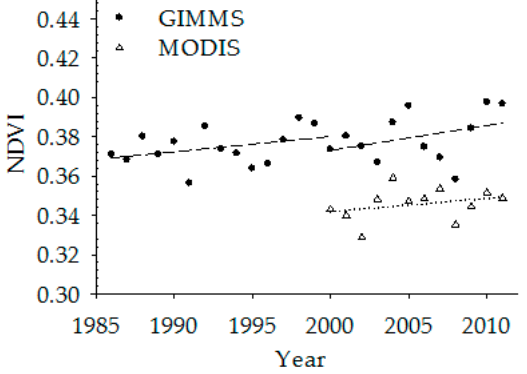
Figure 3. The trend of vegetation vigor in the Qinghai-Tibet Plateau during the period of 1986–2011, prior to 2000, and post 2000, GIMMS NDVI3g (Global Inventory Modeling and Mapping Studies Normalized Difference Vegetation Index) and MODIS NDVI (Moderate Resolution Imaging Spectro-radiometer Normalized Difference Vegetation Index).